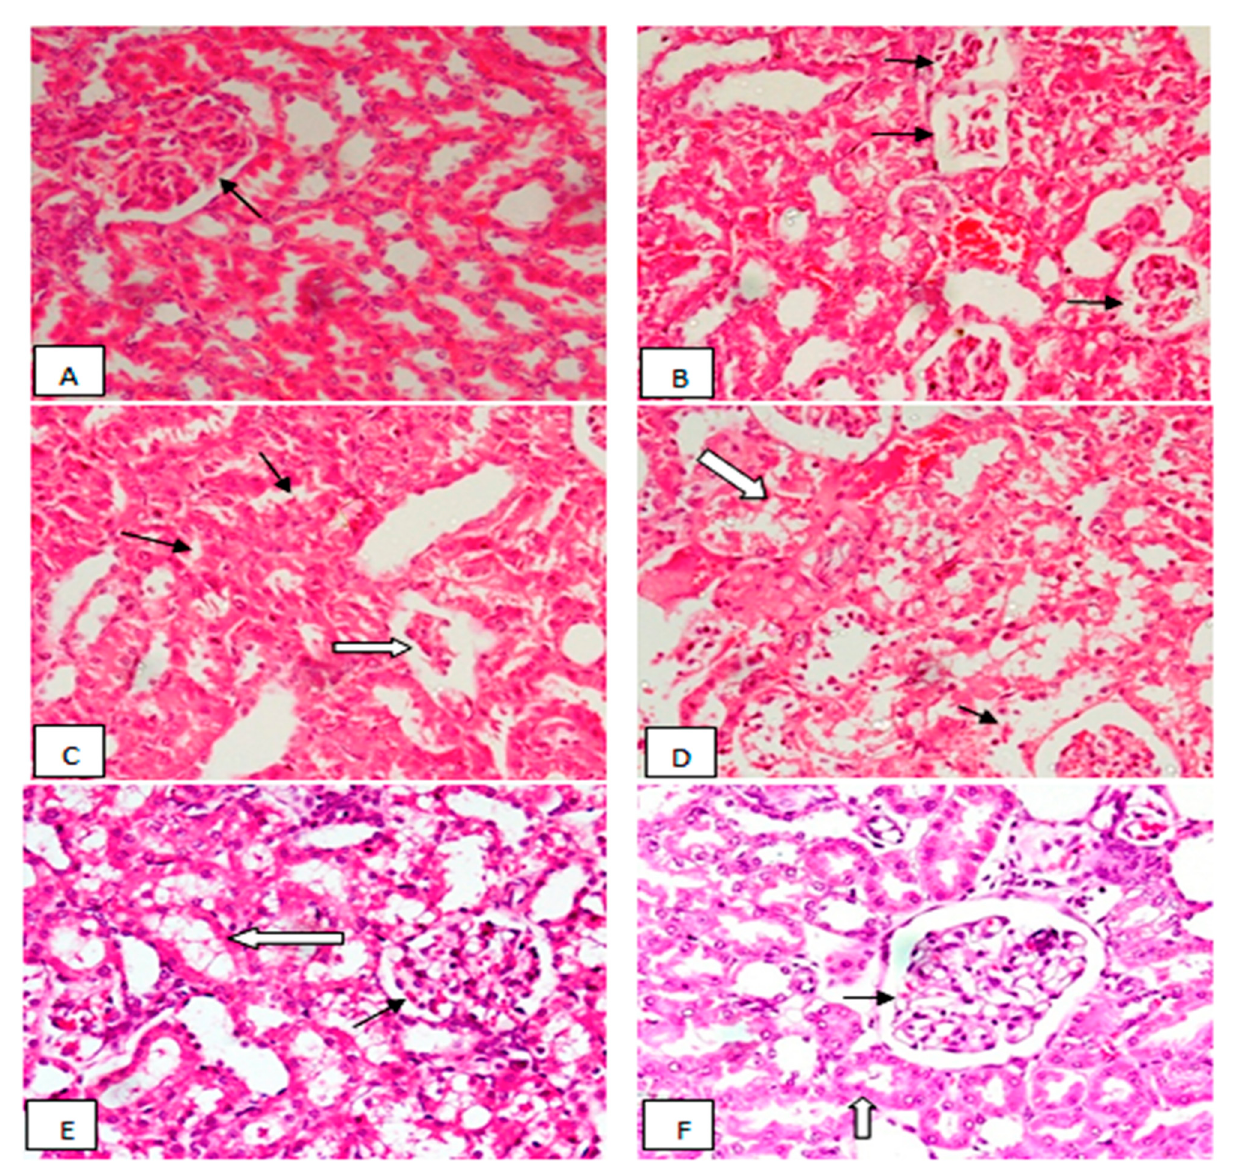
Figure 2. ( A ). Kidney tissue of control rat showing ordinary averagely cellular glomerulus (thin black arrow) amidst ordinary renal tubules, with low cuboidal epithelial lining and patent lumina. ( B ). Kidney tissue of diabetic untreated rat showing degenerated hypocellular glomeruli (thin black arrows) with congestion within interstitial tissue. Thick walled blood vessels were noticed. ( C ). Kidney tissue of diabetic untreated rat showing degenerated hypocellular glomerulus (white arrow) with adjacent renal tubules showing cloudy swelling (thin black arrows) within lining epithelium. ( D ). Kidney tissue of diabetic untreated rat showed renal tubules with vacuolar degeneration (white arrow) within lining epithelium. Other tubules showed atrophic lining (thin black arrow). Interstitial hemorrhages were observed. ( E ). Diabetic rat treated with reference drug showed improved glomerulus as regards cellularity (thin black arrow) with adjacent renal tubules; approximating control (white arrow). ( F ). Renal tissue of diabetic rat treated with compound ( 4 ) showing markedly improved glomerulus (thin black arrow) and the renal tubules (white arrow); the picture approximated control (H&E ×